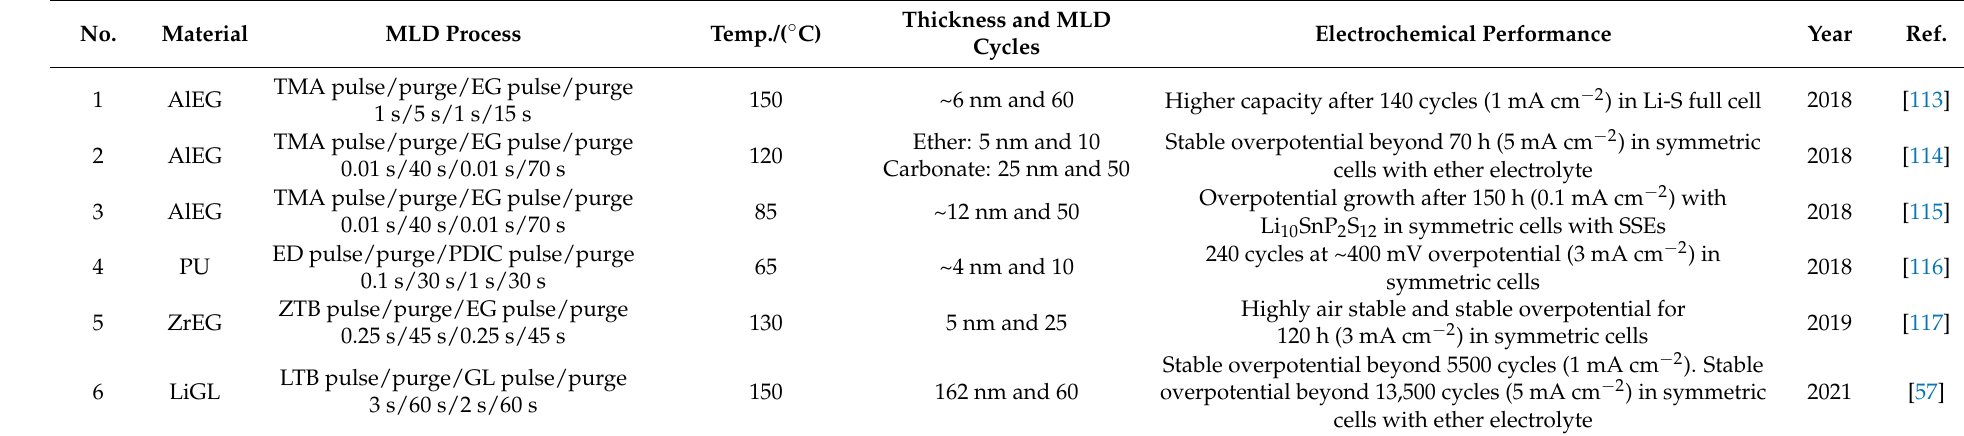
Table 3. Summary of MLD Surface Coating Li Metal.